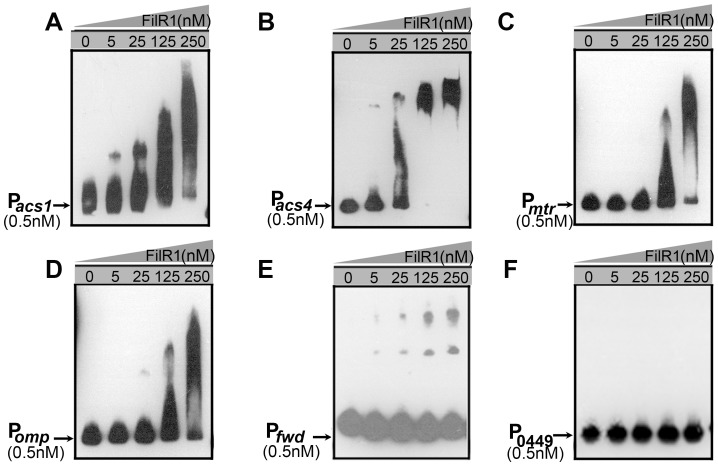
EMSAs showed FilR1 binding to the promoters of genes key to methanogenesis in M. harundinacea.Purified recombinant FilR1 protein was incubated with 0.5-labeled DNA in the standard binding reaction mixture for 20 min at 25°C and then run on a native PAGE. Concentration of purified FilR1 protein used was shown at the top of each lane. (A) Pacs1, promoter of the acs1 operon; (B) Pacs4, promoter of acs4; (C) Pmtr, promoter of the mtr operon; (D) PfwdCABD, promoter of the fwdCABD operon; (E), Pomp, promoter of omp; and (F) PMhar_0449, promoter of Mhar_0449.